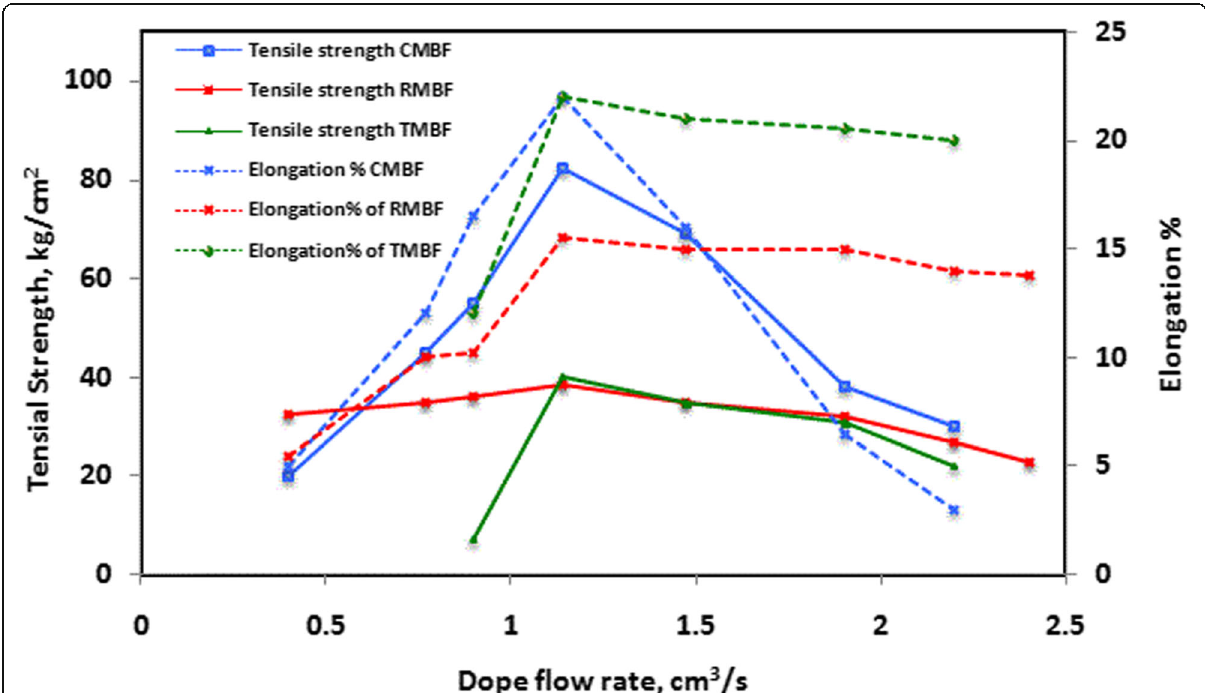
Fig. 14 Effect of dope solution flow rate on the tensile strength and elongation % at different configuration